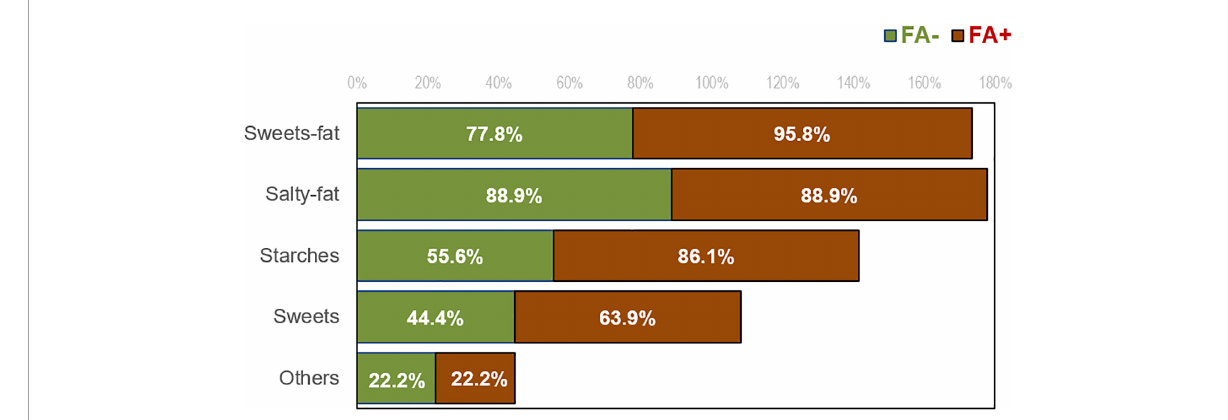
FIGURE1 Distribution of the self-reported problematic type of foods in patients with FA negative and positive score.